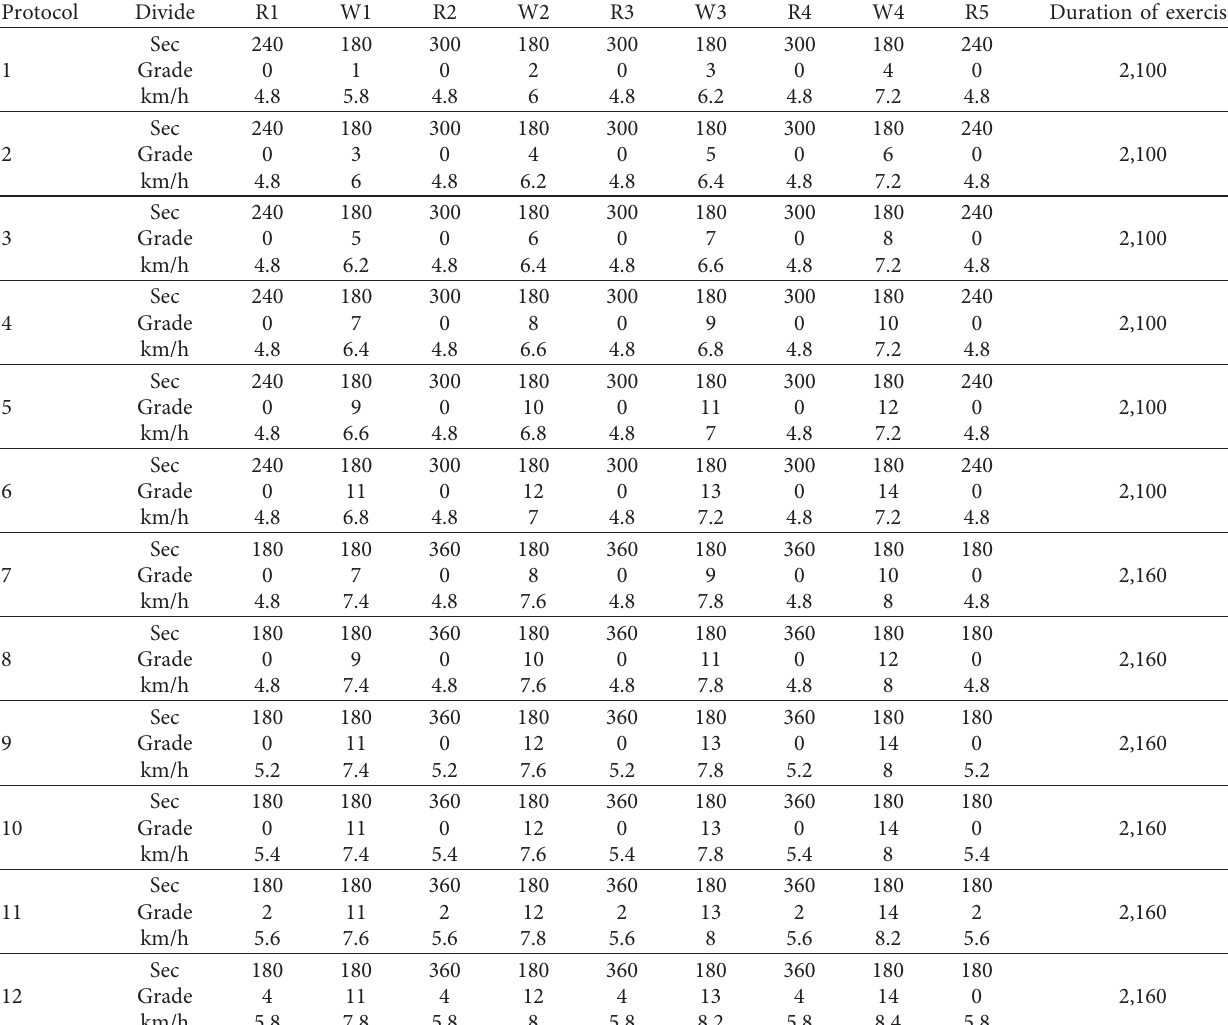
Table 3: Interval exercise program consisting of 12